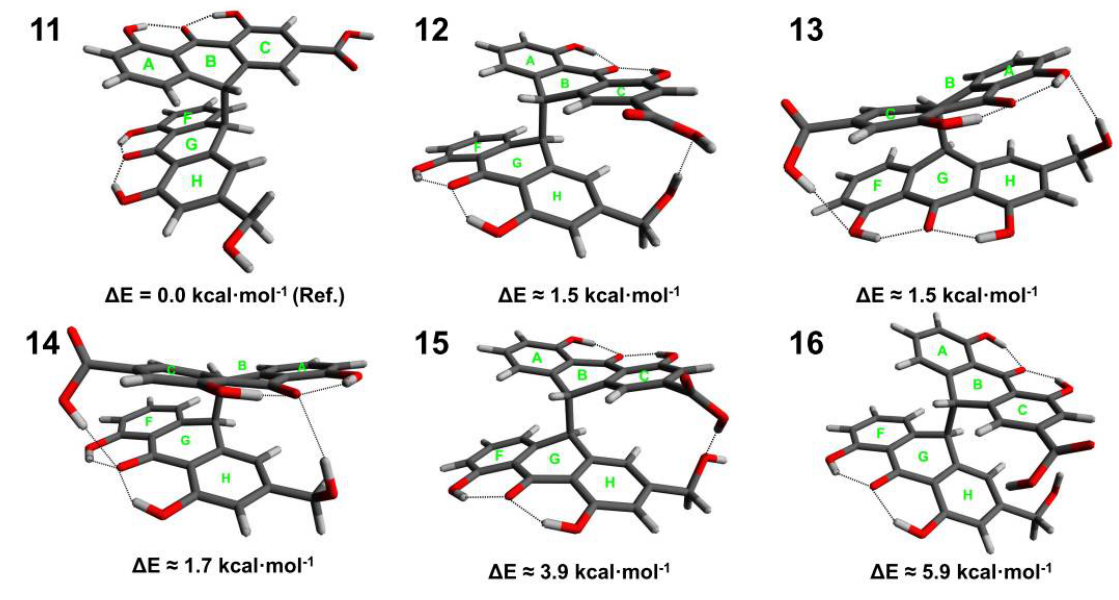
Figure 3. Conformers ( 11 – 16 ) of sennidin C.